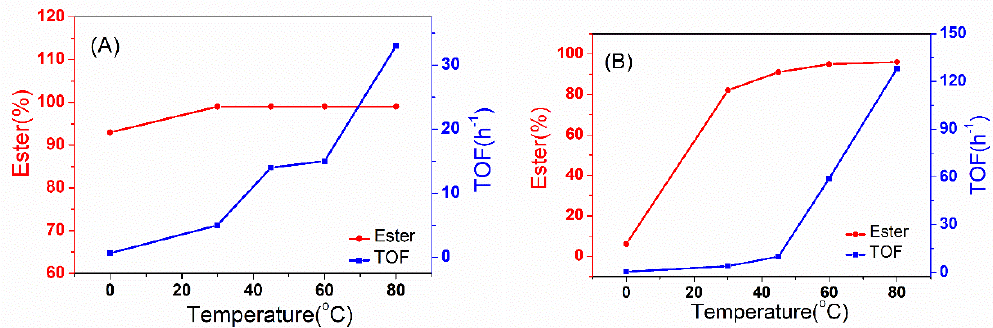
Figure 4. The effect of temperature on turnover of frequency (TOF) values and ester content of the SA / PO copolymerization catalyzed by TEB / t -BuP 1 pairs with the molar ratio of ( A ) 1 / 1; ( B ) 4 / 1.